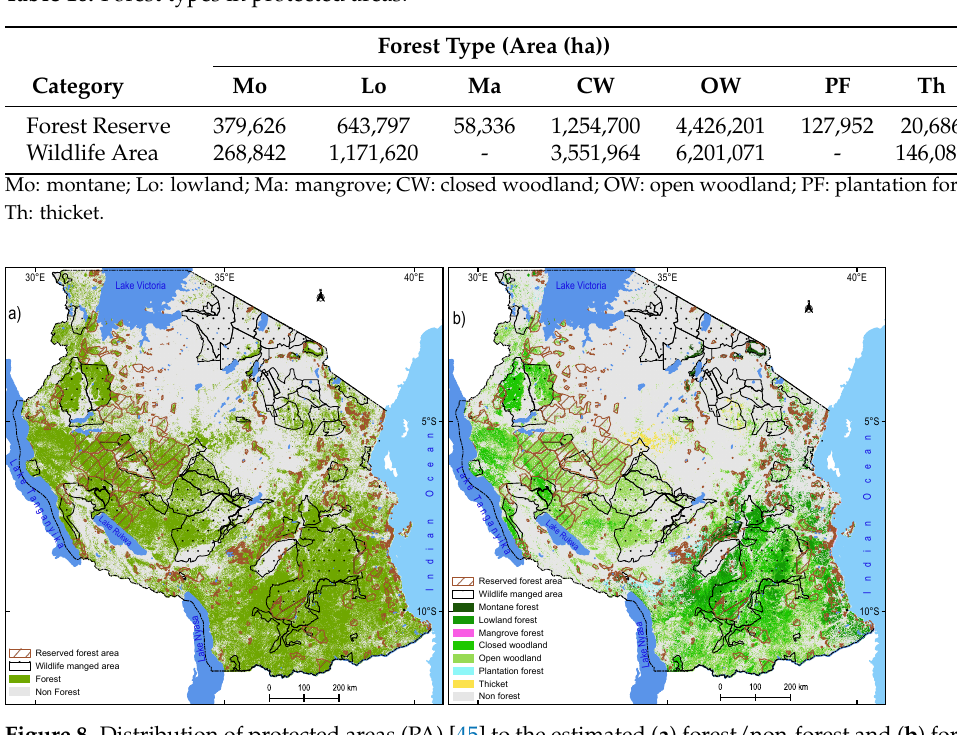
Table 10. Forest types in protected areas.